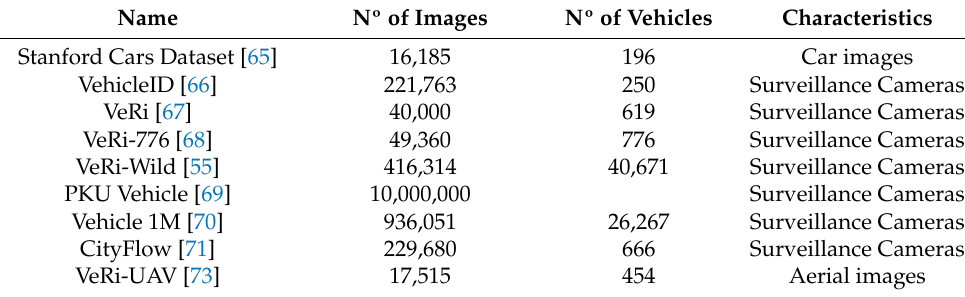
Table 4. Main vehicle re-identification